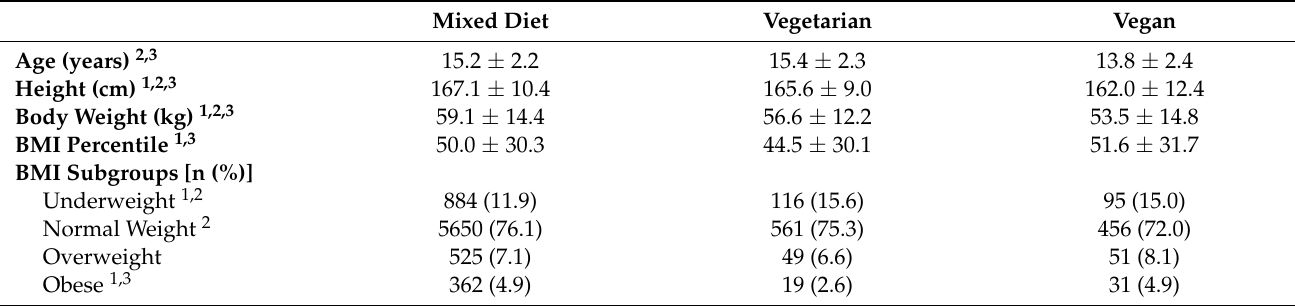
Table 6. Anthropometric characteristics by dietary pattern. Values are presented as means ± SD for the first four variables and prevalence for BMI